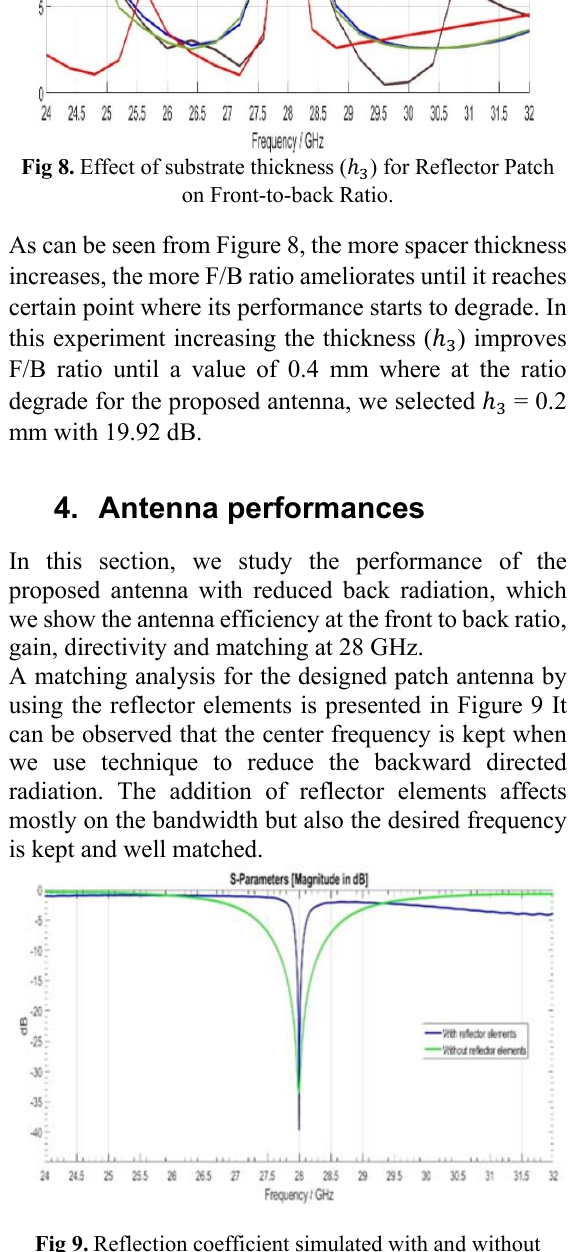
Fig 10. Radiation pattern of the proposed antenna at 28 GHz (expressed in dB). (a) E-Plane. (b) H-Plane. (c) 3D radiation